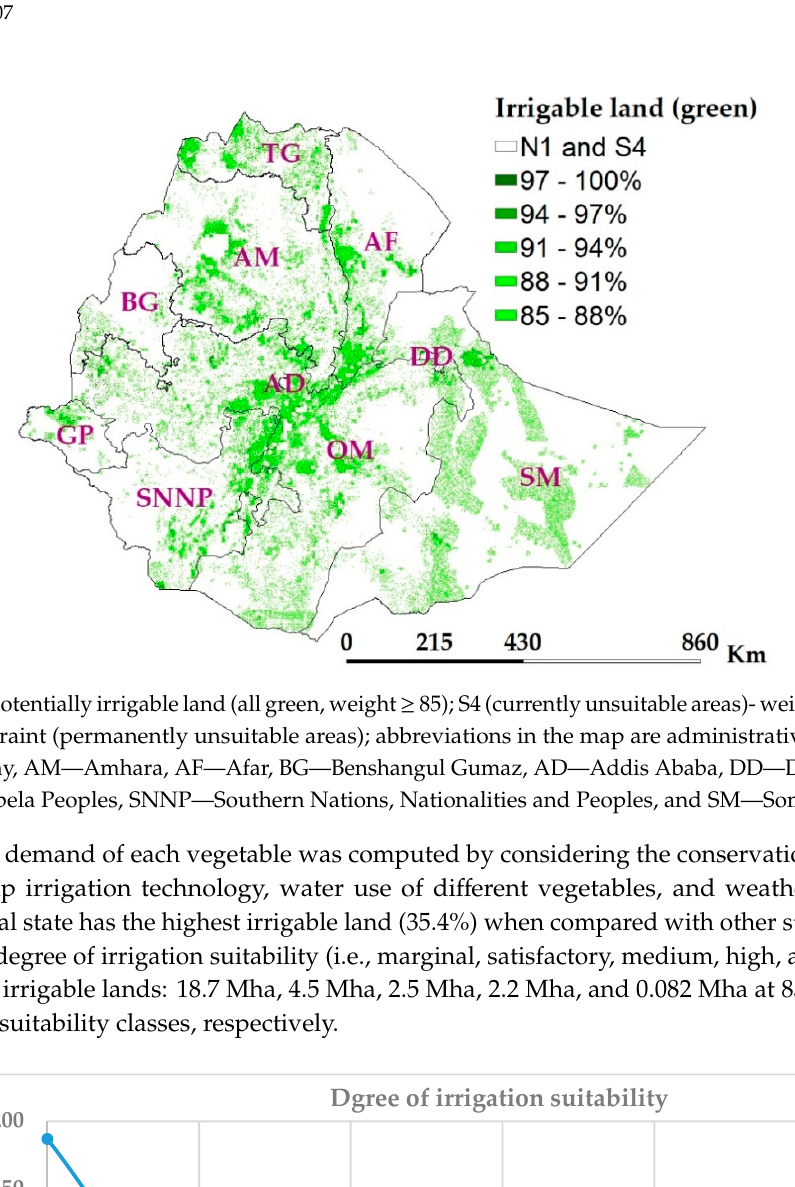
Figure 5. Degree of irrigation suitability for the potentially irrigable land.